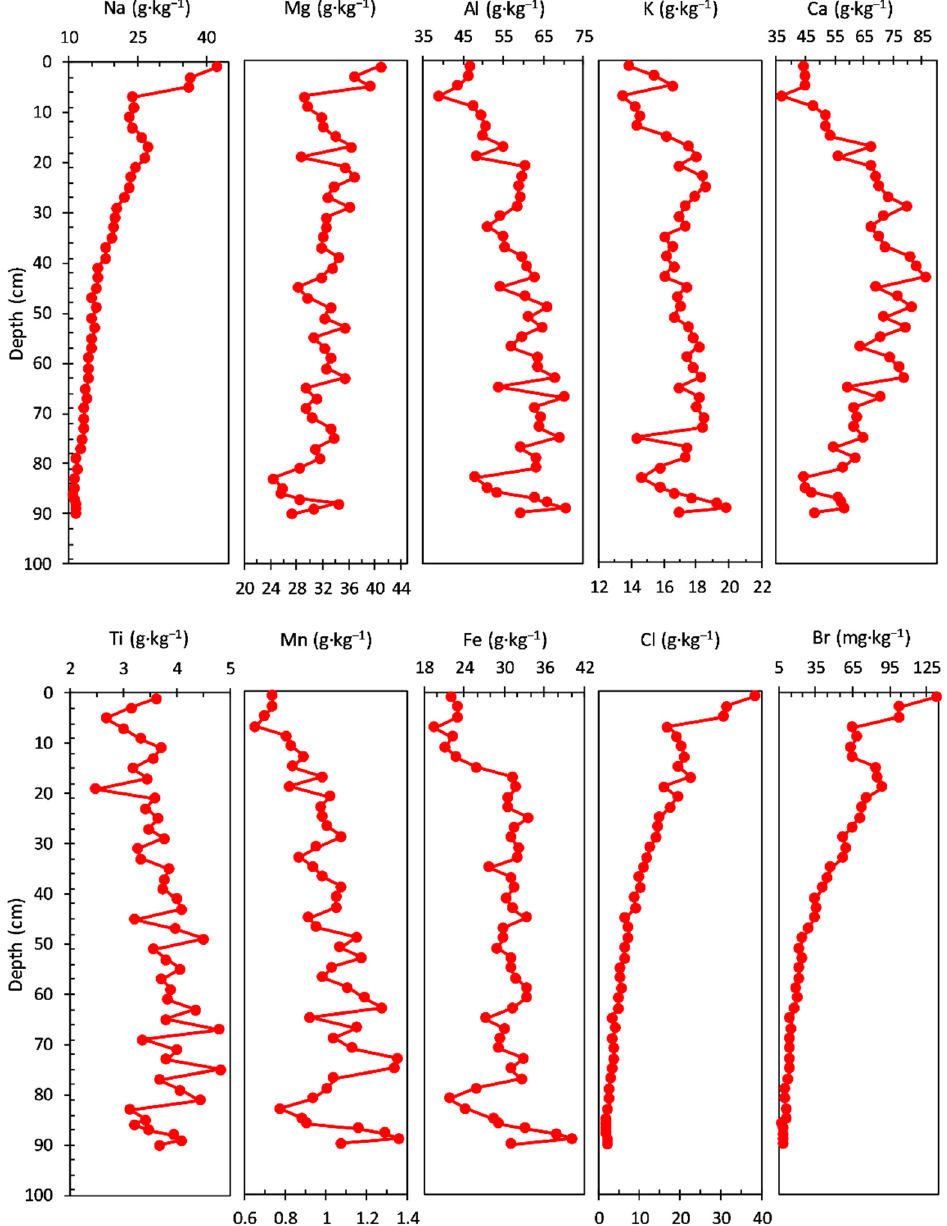
Figure 10. Vertical distribution of geochemical main elements (Na, Mg, Al, K, Ca, Ti, Mn, Fe, Cl, Br) in the Movila Miresii Lake sediment core (90 cm depth). The concentration profiles of Na (ranged from 11.20 to 42.40 g·kg − 1 , with an average value of 18.45 g·kg − 1 ), Cl (ranged from 1.75 to 38.40 g·kg − 1 , with an average value of 10.34 g·kg − 1 ), and Br (ranged from 8.57 to 134.00 mg·kg − 1 , with an average value of 40.78 mg·kg − 1 ) show a gradual increase in concentration structured on the depth, from the bottom to the